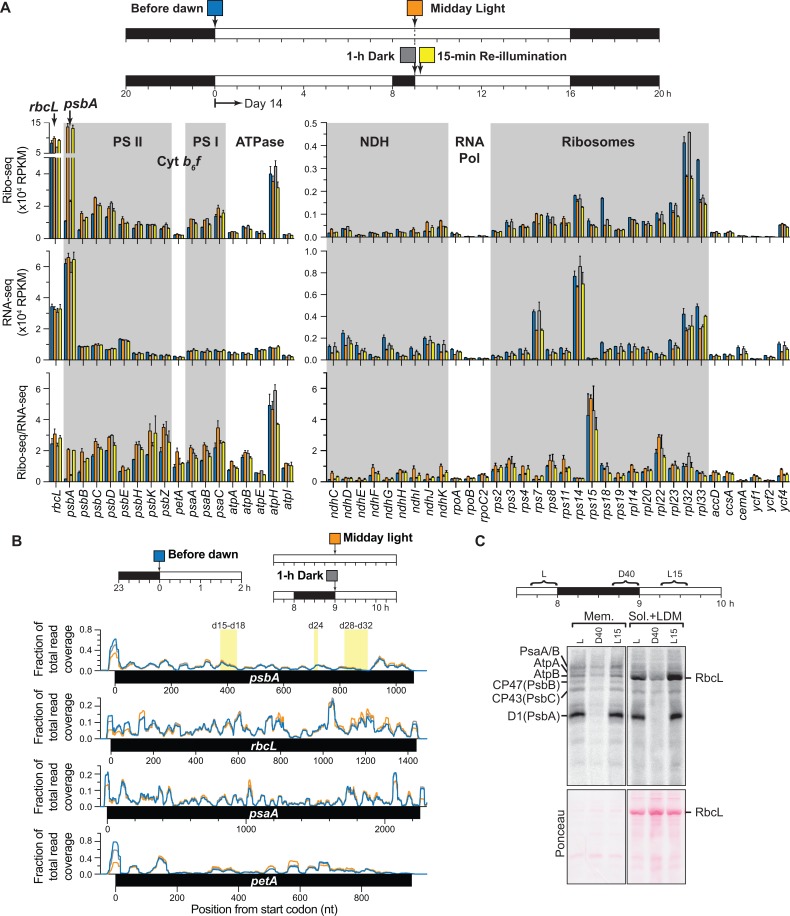
Chloroplast ribosome occupancy and protein synthesis in Arabidopsis following light-to-dark and dark-to-light shifts.(A) Seedlings were grown for 13-days in 12-h light/12-h dark cycles and subjected to the indicated light shifts on day 14. The normalized abundance of ribosome footprints (Ribo-seq), RNA (RNA-seq), or ribosome density (Ribo-seq/RNA-seq) is shown for each gene under each of the four indicated conditions. The values are the mean ± SEM from two biological replicates. Genes for which mRNA levels could not be measured with confidence are excluded. These include short ORFs (<150 nucleotides) and intron-containing genes. (B) Normalized read coverage for each of the three conditions diagrammed at top is plotted according to nucleotide position in each indicated ORF. Values are the sum from two replicates. Regions in psbA corresponding to major ribosome pause sites detected by toe-printing in barley are shaded in yellow and labeled as in the original report [19, 20]. (C) Chloroplast protein synthesis in Arabidopsis in response to light shifts at midday. 35S-methionine/cysteine was applied to excised seedling leaves in the presence of cycloheximide. Labeling was initiated at the indicated times and continued for 20 min. After separating dense membranes (Mem) from soluble and low-density membranes (Sol+LDM), proteins were resolved by SDS-PAGE, transferred to nitrocellulose, and detected by phosphorimaging. Bands corresponding to D1 (PsbA), CP47 (PsbB), CP43 (PsbC), PsaA/B, AtpA, AtpB, and RbcL are marked. The Ponceau S-stained nitrocellulose blots used for phosphorimaging are shown below. The recovery of radiolabeled D1 in the Sol+LDM fraction was likely due to inefficient pelleting of stromal lamellae, the site of PSII repair.